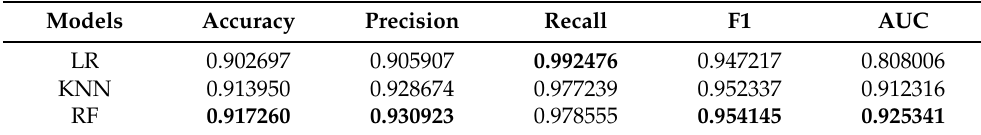
Table 7. Comparison of different models prediction